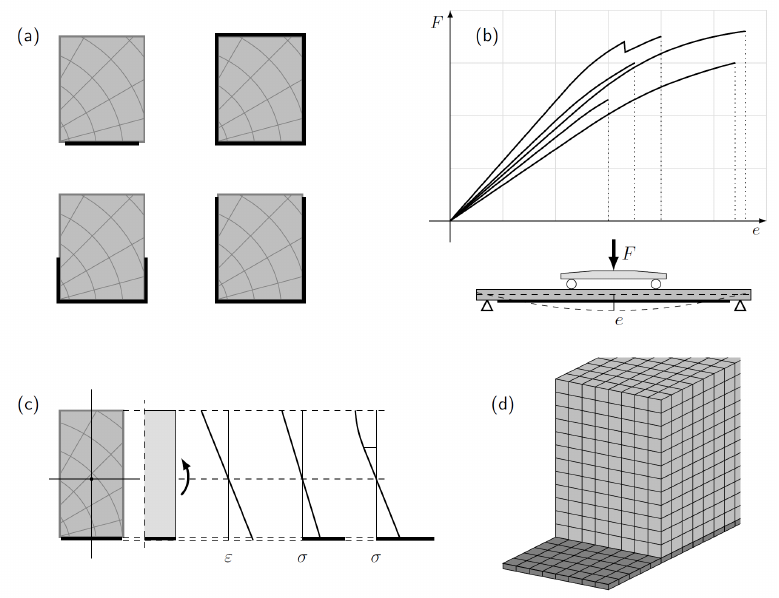
Figure 3. Experimental and numerical analysis of reinforced timber beams. ( a ) Possible cases of externally bonded FRP applied on timber beams, ( b ) common four-point bending test arrangement and typical load-deflection curves in schematic plot, ( c ) uniaxial strain and stress distribution in the classical beam theory considering linearity in tension and linearity or nonlinearity in compression parallel to grain, ( d ) schematic plot of typical 3D finite element model of reinforced beams with block